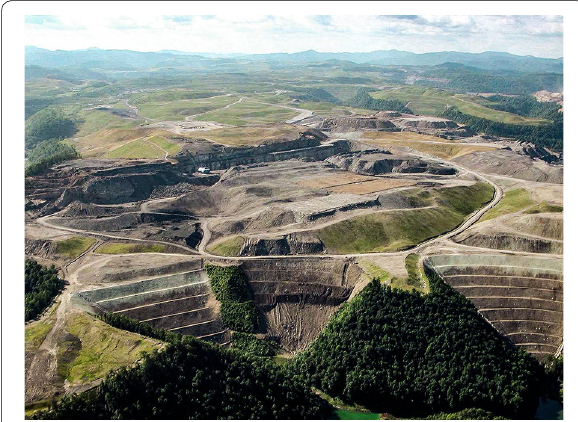
Fig. 2 Kayford mountain, MTR site after reclamation. Photo: Vivian Stockman with the Ohio Valley Environmental Coalition; Flyover courtesy